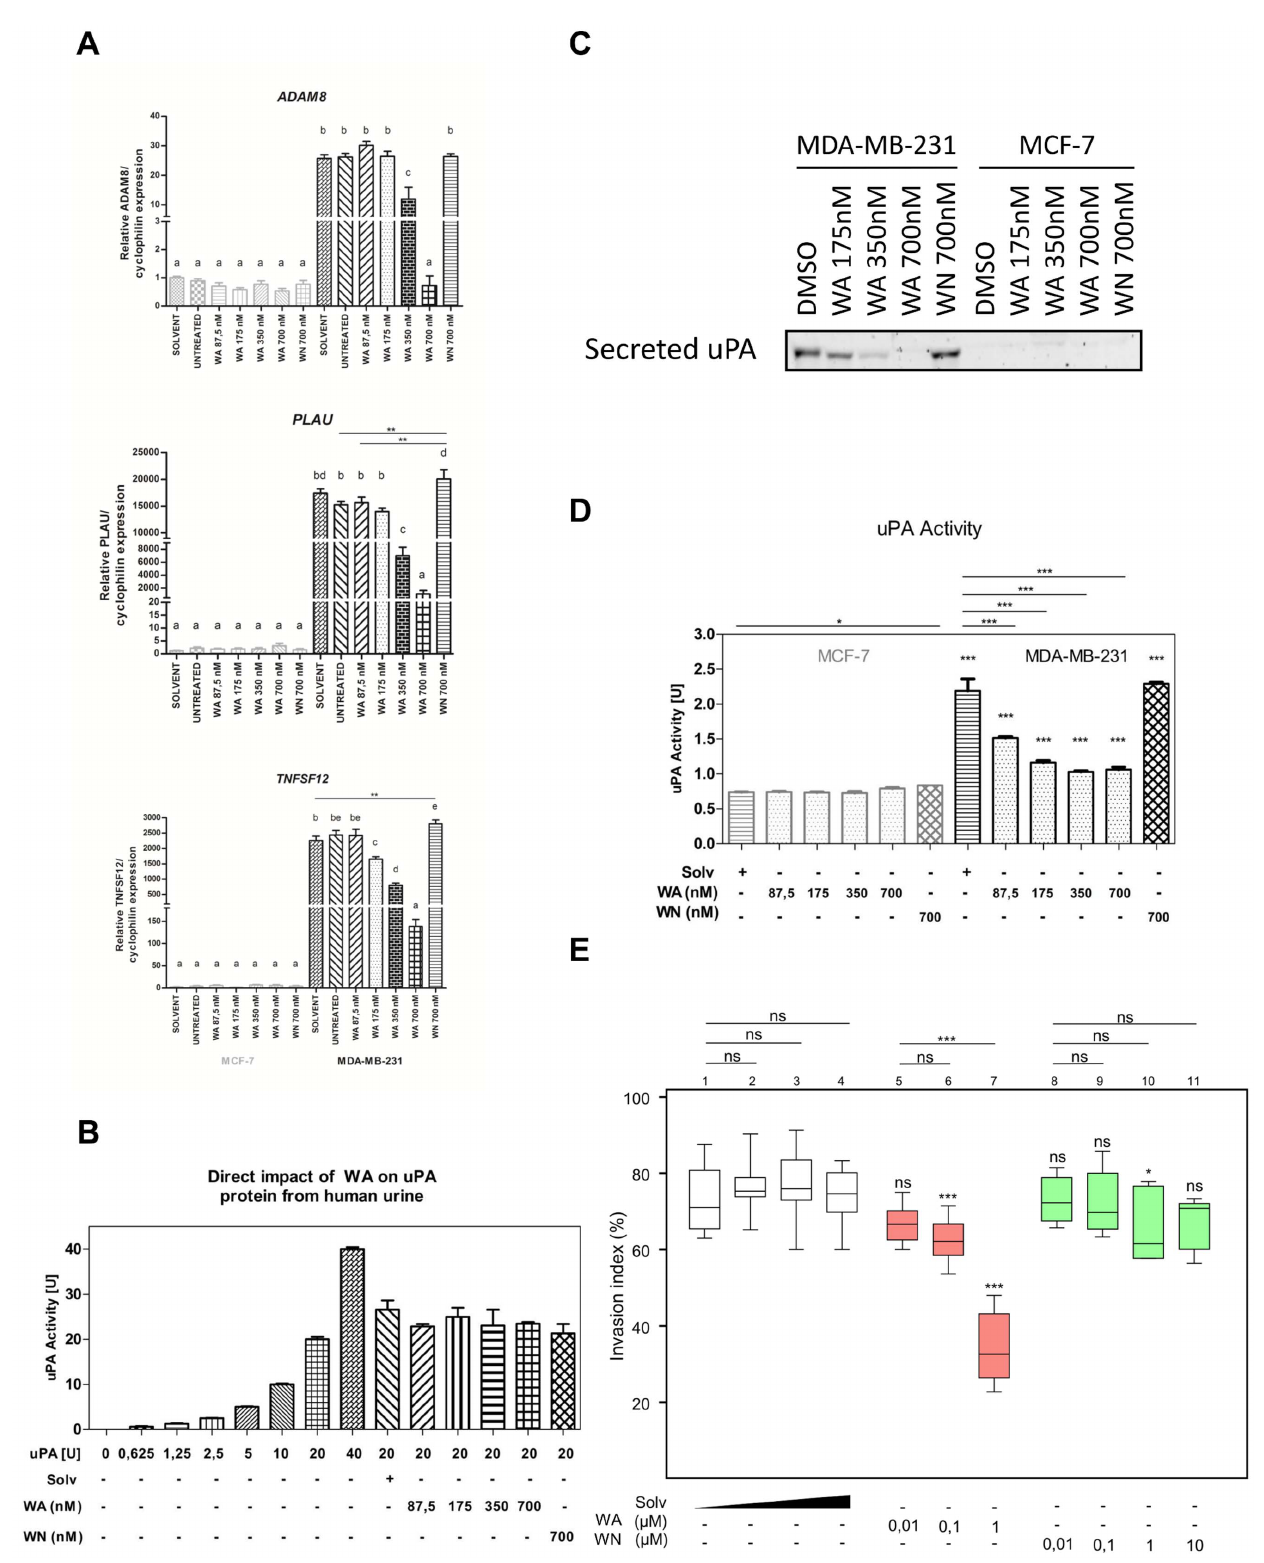
Figure 5. Decreased invasiveness of WA-treated MDA-MB-231 cells is associated with changed expression of ECM remodeling and pro-inflammatory genes. (A) Effect of WA, WN on ADAM8 , PLAU and TNFSF12 gene expression in MCF-7 and MDA-MB-231 cell lines normalized to cyclophilin housekeeping gene and relative to DMSO-treated MCF-7 sample (2 - DD Ct ) as determined by real-time quantitative PCR. Bar graphs represent relative mRNA (mean 6 SEM) levels of three independent experiments. (B) Direct effect of WA, WN or DMSO on activity of uPA protein from human urine. Bar graphs represent mean 6 SEM uPA activity of two independent experiments (C) Effects of DMSO, WN or WA at three different